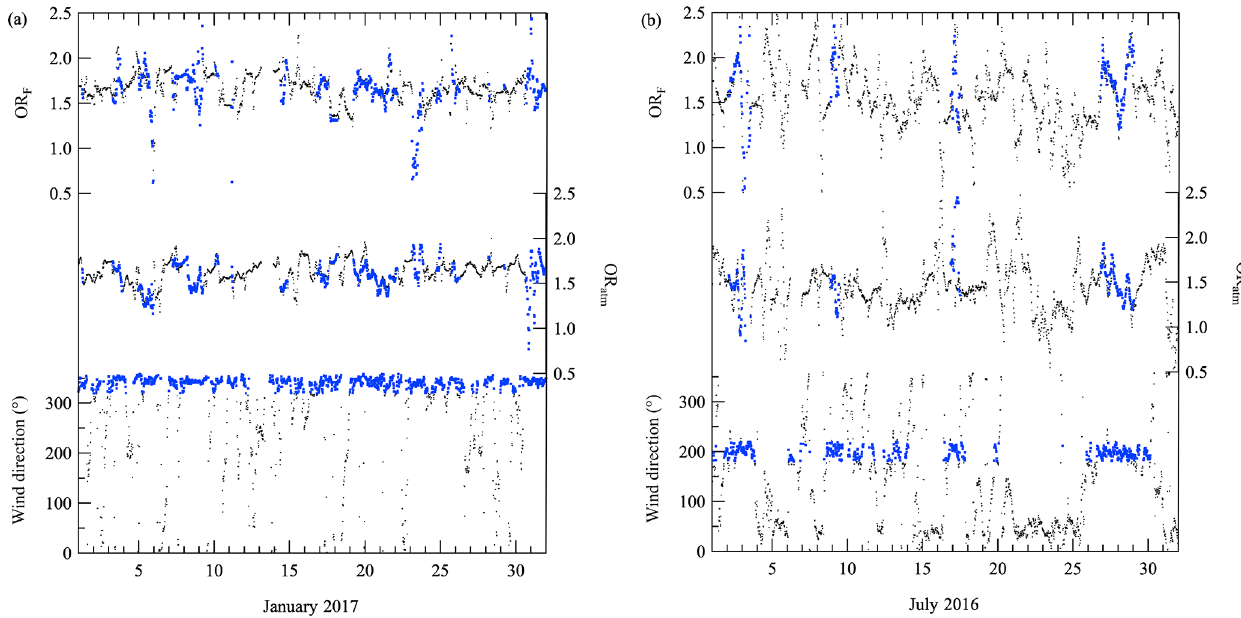
Figure 6. (a) OR F (black dots, top) calculated by applying Deming regression fitted to (cid:49) O 2 and (cid:49) CO 2 values during the successive 12h periods observed in January 2017. The corresponding OR atm (black dots, middle) obtained from the deviations of O 2 and CO 2 concentrations from their baseline variations shown in Fig. 4, and the wind directions (black dots, bottom), are also shown. Angles of 90, 180, 270 and 360 ◦ for the wind direction denote winds from east, south, west and north, respectively. The OR F and OR atm obtained from the data observed during the period with the prevailing wind direction (blue dots, bottom) are also shown by blue dots. (b) Same as in (a) but for July